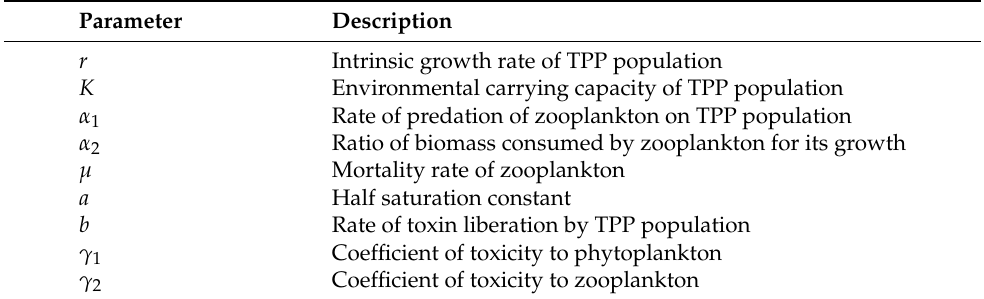
Table 1. Biological explanation of parameters in model